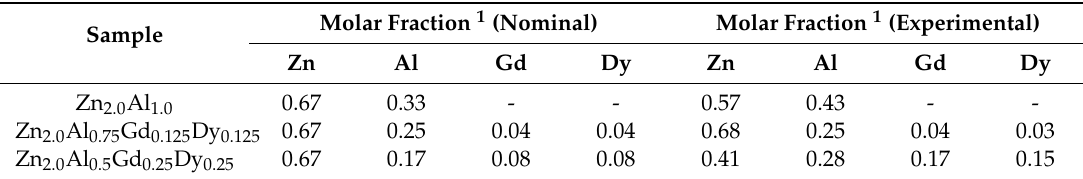
Table 4. Molar fractions of metal cations in the